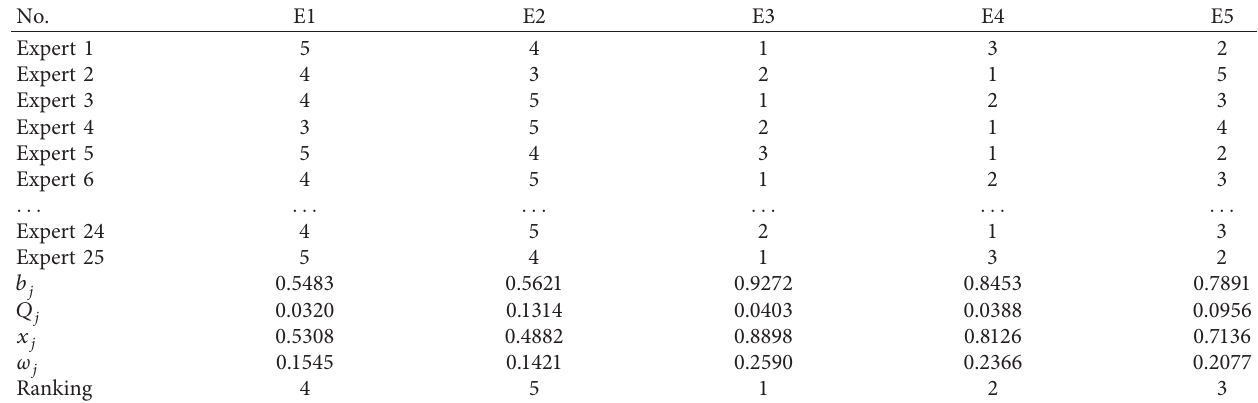
Table 7: The weights of 5 secondary indexes related to the environment.